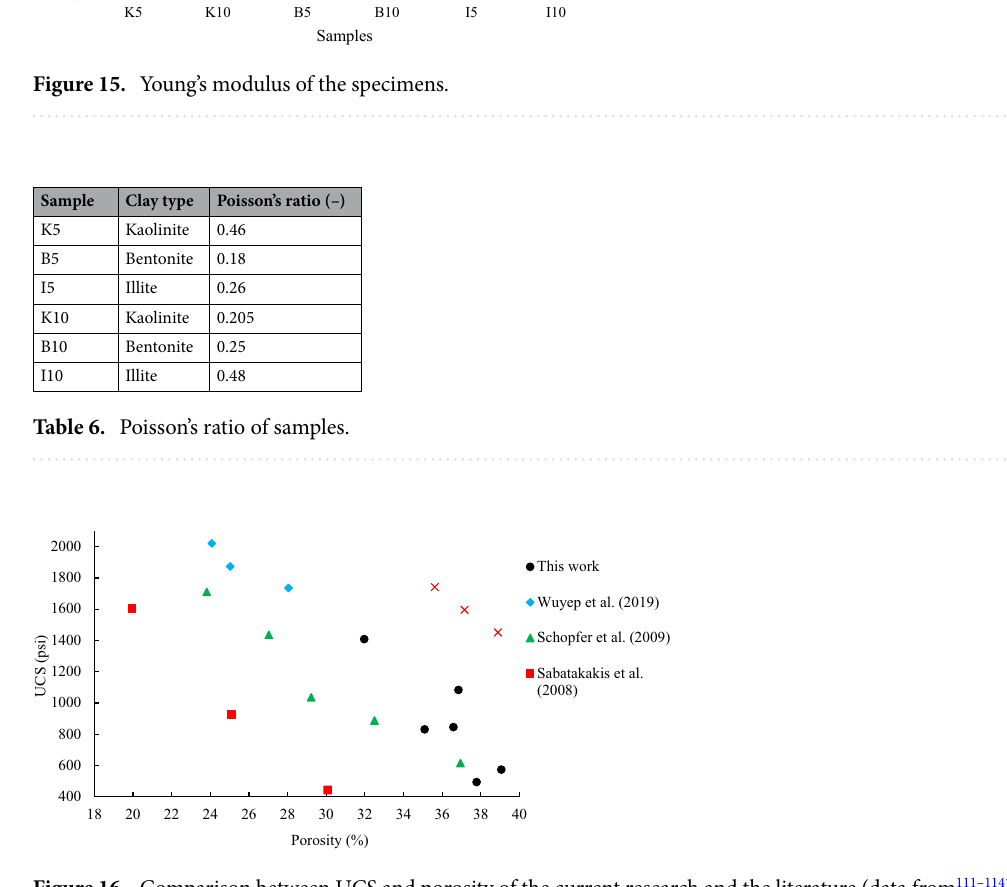
Figure 16. Comparison between UCS and porosity of the current research and the literature (data from 111–114